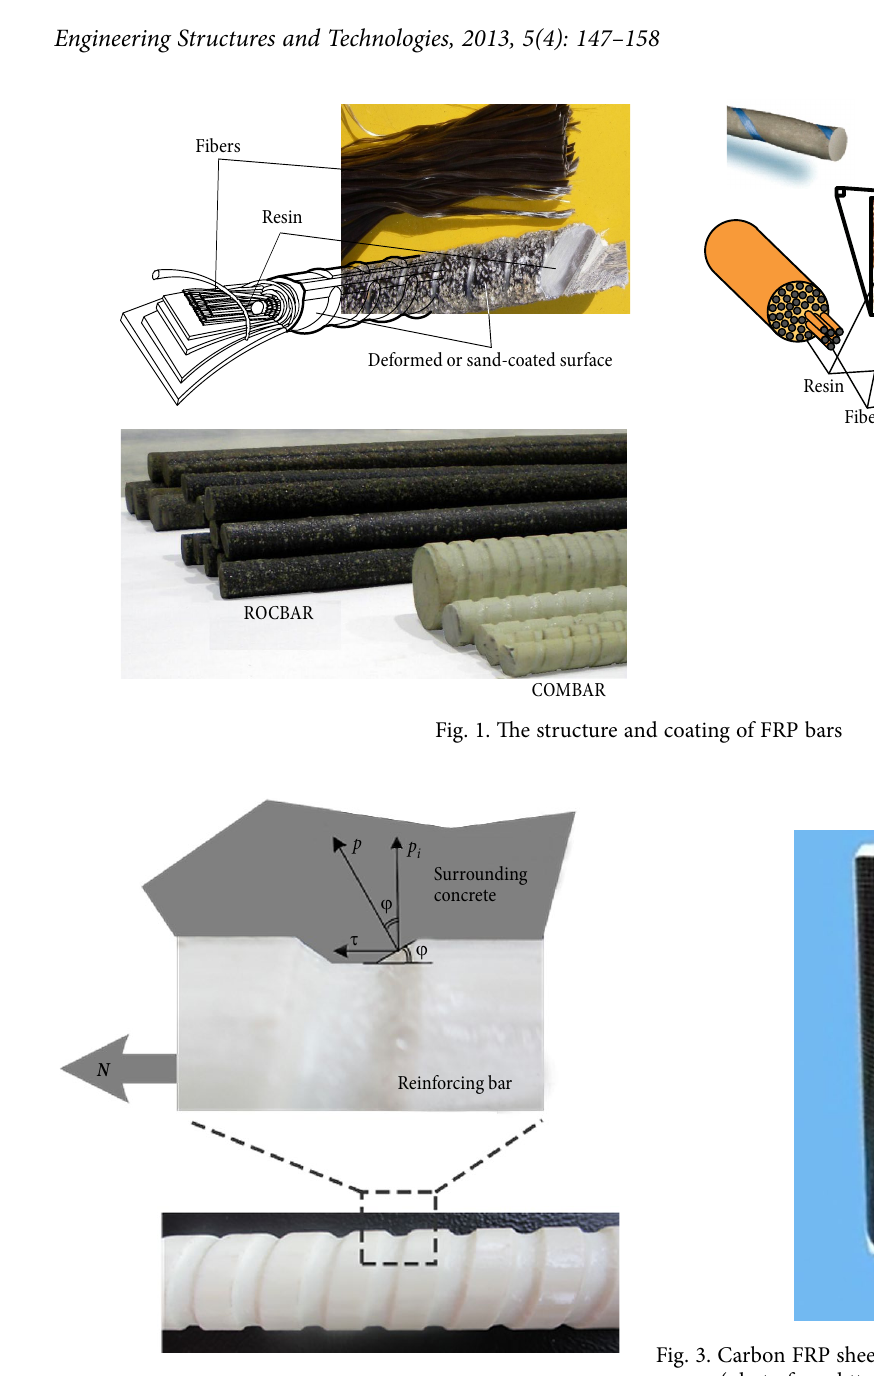
Fig. 2. Bond action of Schöck ComBAR reinforcement